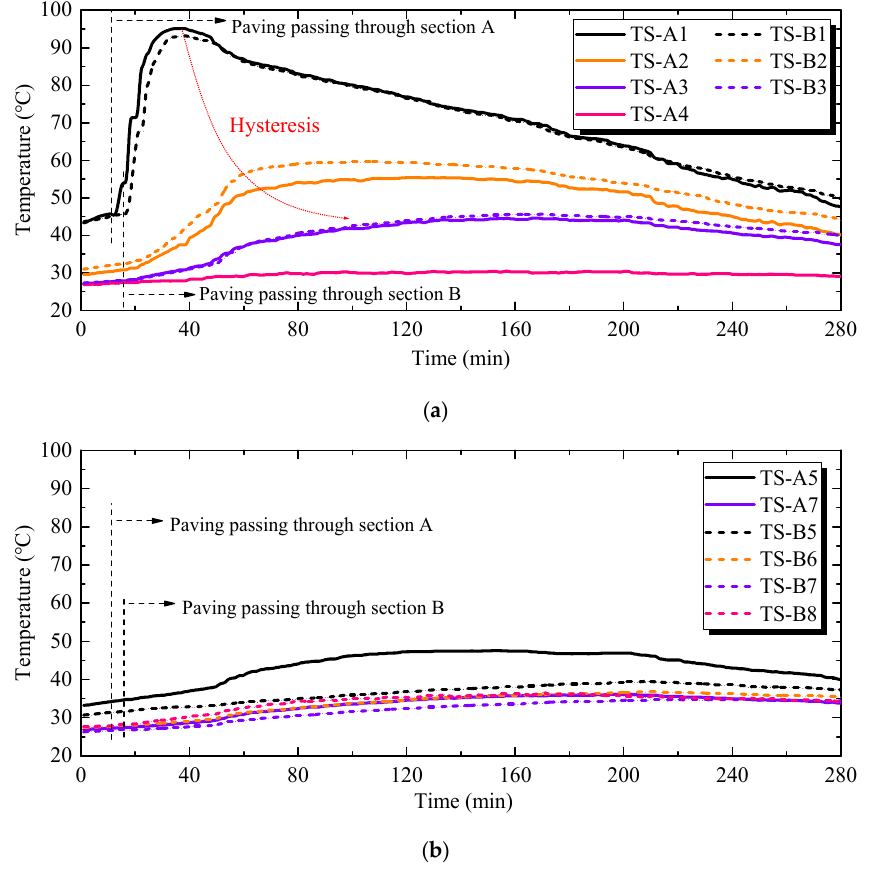
Figure 5. Variation of monitored temperatures. ( a ) TS-A1 (B1) to TS-A4 (B4); ( b ) TS-A5 (B5) to TS-A8 (B8).